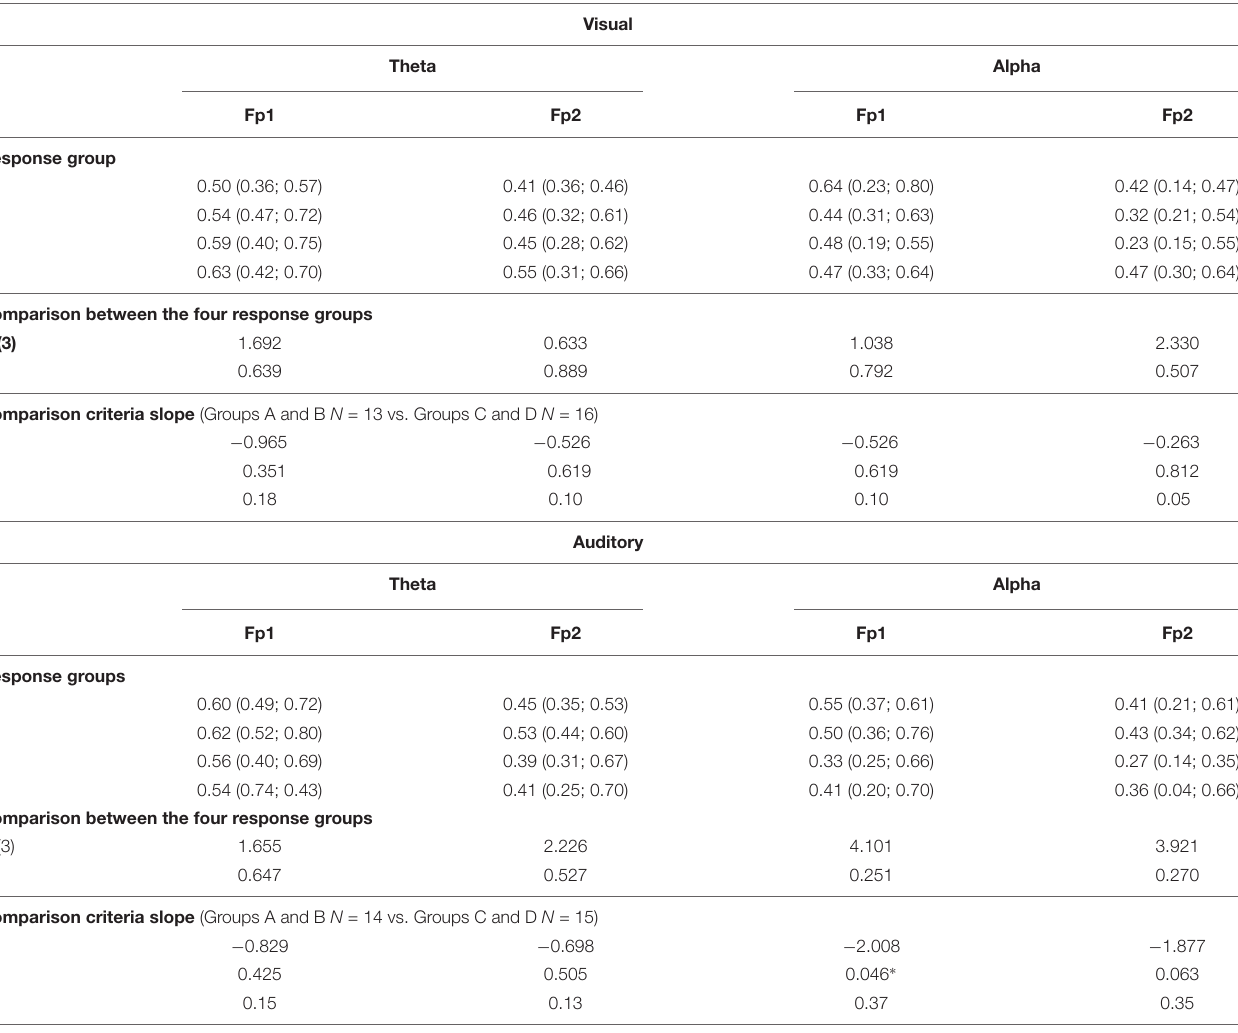
TABLE 4 | Comparison of prefrontal cortex log-transformed power in theta and alpha frequency bands during the divided attention test between the different response groups.